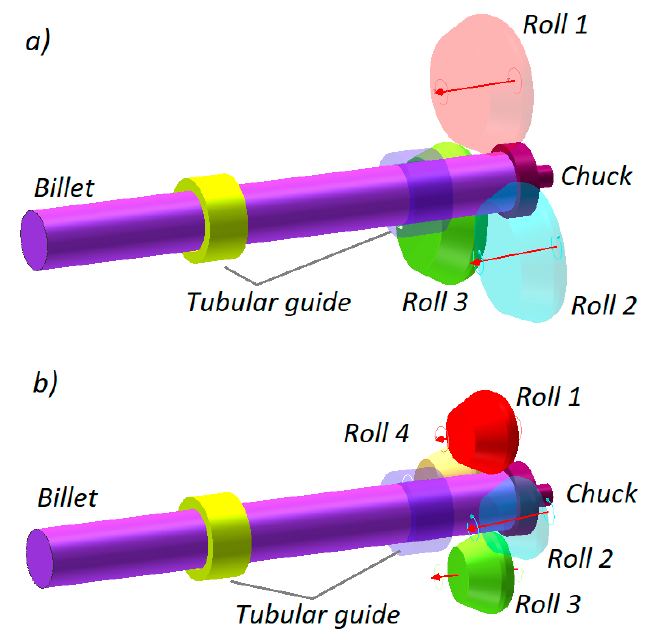
Figure 4. Geometrical models of rolling a railway axle from a solid billet: ( a ) in a 3-roll mill, ( b ) in a 4-roll mill.